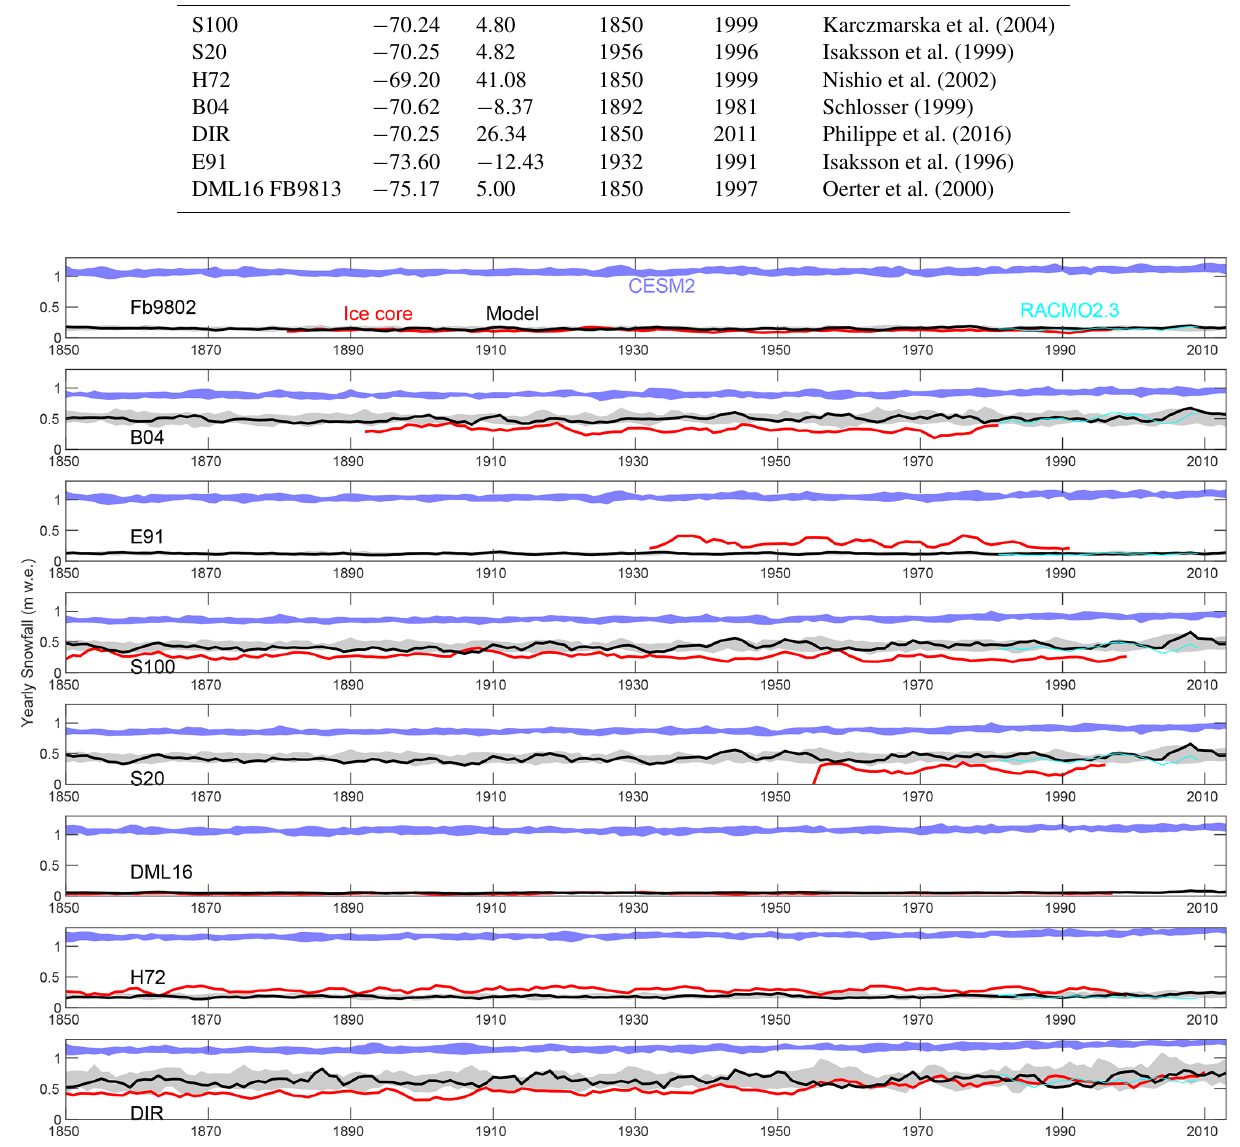
Figure 8. The time series of yearly accumulated snowfall extracted from the database (CESM2 member 1, training with ERA-Interim and all members in shaded gray) is compared to the SMB estimated from ice cores available from Thomas et al. (2017) (ice core data available on the web page of Antartica2k (sub-group of PAGES2k, https://pastglobalchanges.org/science/wg/2k-network/projects/antarctica2k/intro, last access: 19 April 2022) and at https://data.bas.ac.uk/full-record.php?id=GB/NERC/BAS/PDC/00940, last access: 19 April 2022). The RACMO2.3 time series has been superimposed (cyan), and the 10 CESM2 simulations (shaded blue) show the large bias reduction thanks to the use of RACMO2.3 for the training. A 4-year moving average has been applied to the time series for the